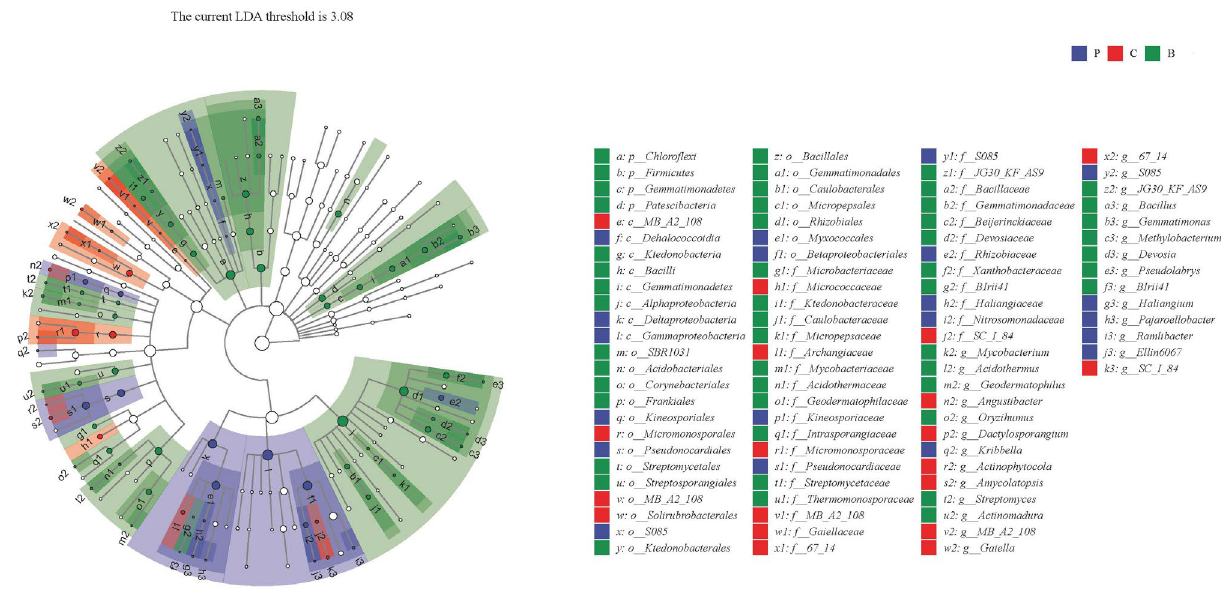
Figure 4. LEfSe taxonomic cladogram. The colored nodes from inner circle to outer circle represent the hierarchical relationship of all taxa from the phylum to the genus level. Taxa enriched in B group are shown in green while taxa enriched in C group are shown in red and taxa enriched in P group are colored in blue. Taxa with no significant difference between groups are hollow nodes, while these taxa with significant difference between groups are the nodes of other colors (bule, green and red). P, C, and B represent hydroxyapatite addition, no amendments, and biochar addition, respec- tively.